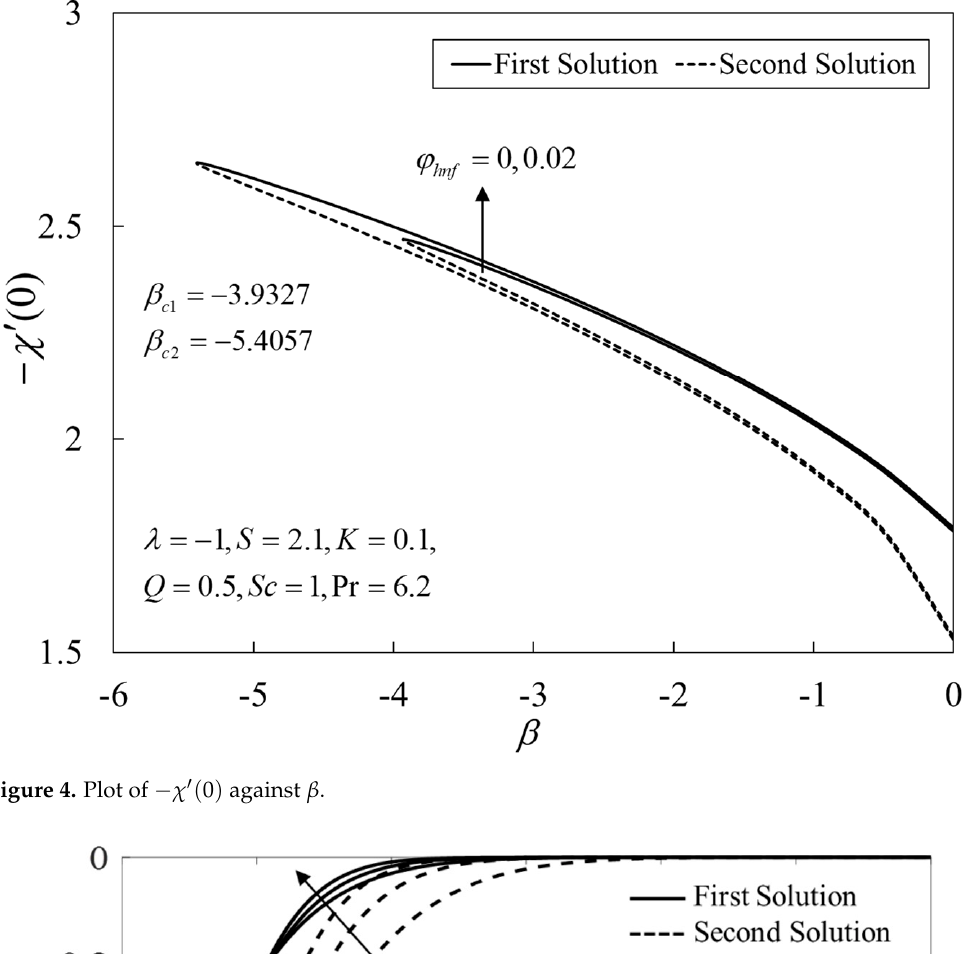
Figure 3. Plot of (0)  against  .